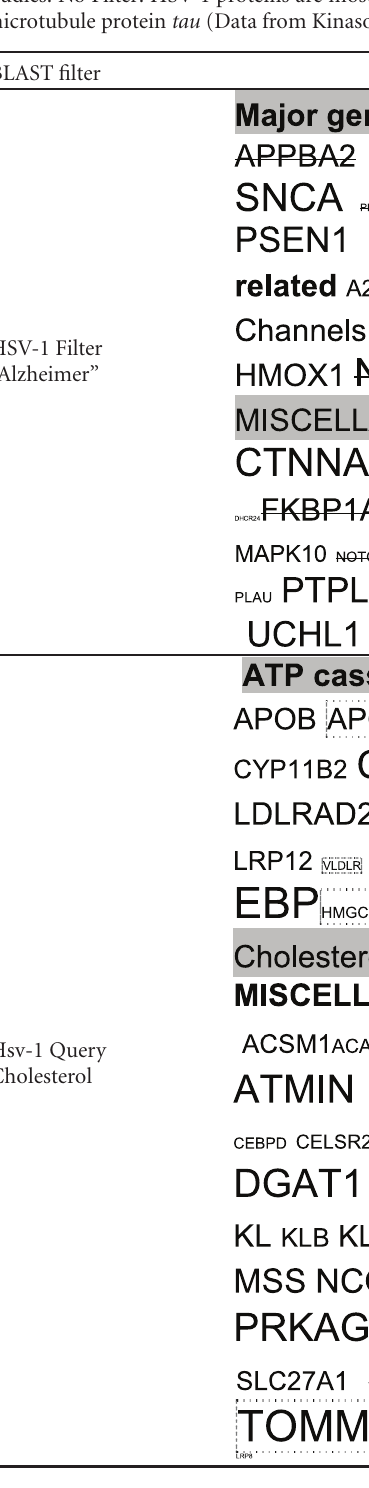
Table 2: Human proteins with homology to HSV-1 proteins: The size of symbol (HUGO Nomenclature approved gene symbols) is proportional to the number of viral proteins displaying homology to the gene product. Filter “Alzheimer”: all of the genes encoding for these proteins with the exception of those with the strikethrough have been implicated in Alzheimer’s disease in genetic association studies. Filter “cholesterol”: genes encoding for proteins products in dashed boxes have been implicated in Alzheimer’s disease in genetic association studies. No Filter: HSV-1 proteins are most homologous to diverse families of kinases: Those boxed have been shown to phosphorylate